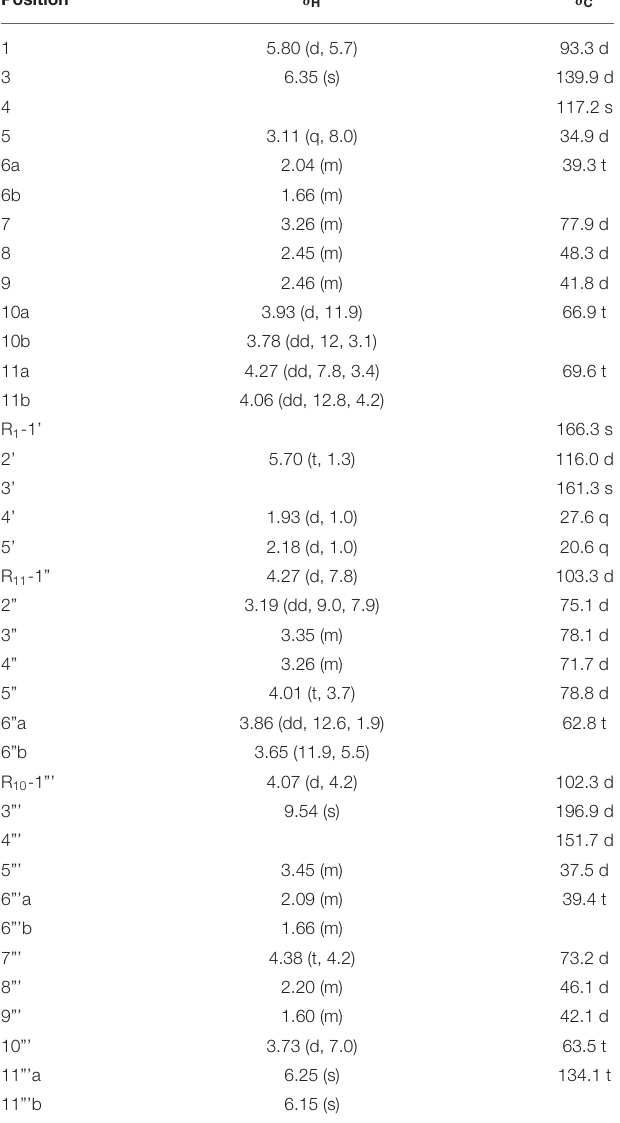
TABLE 3 | The 1 H and 13 C NMR data of 10 (CD 3 OD δ in ppm, J in Hz).